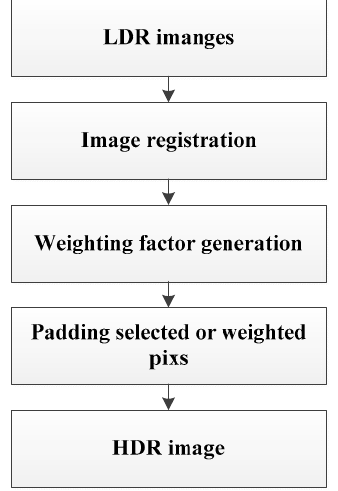
Figure 2. Tone mapping processing chain.